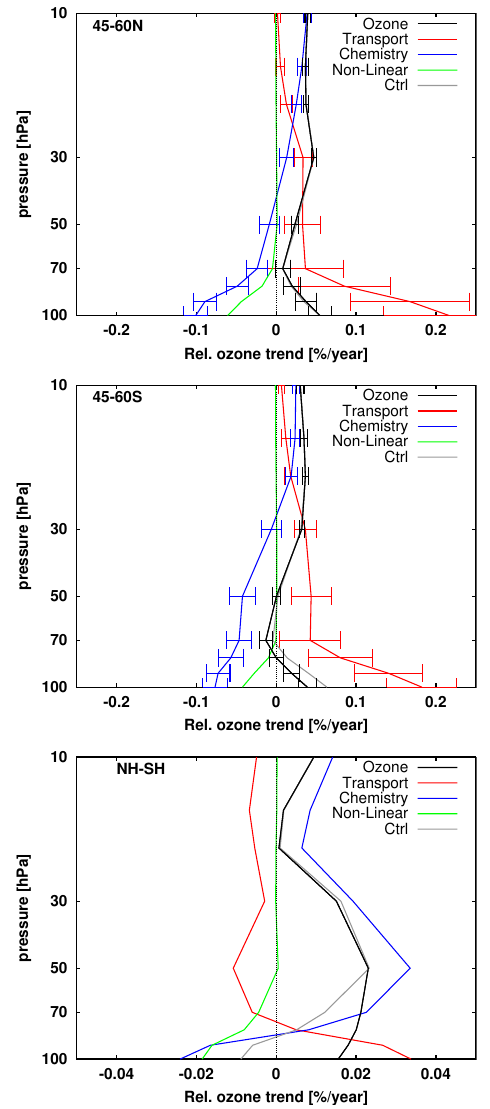
Fig. 10. As in Fig. 8 but for lower stratospheric ozone trends in